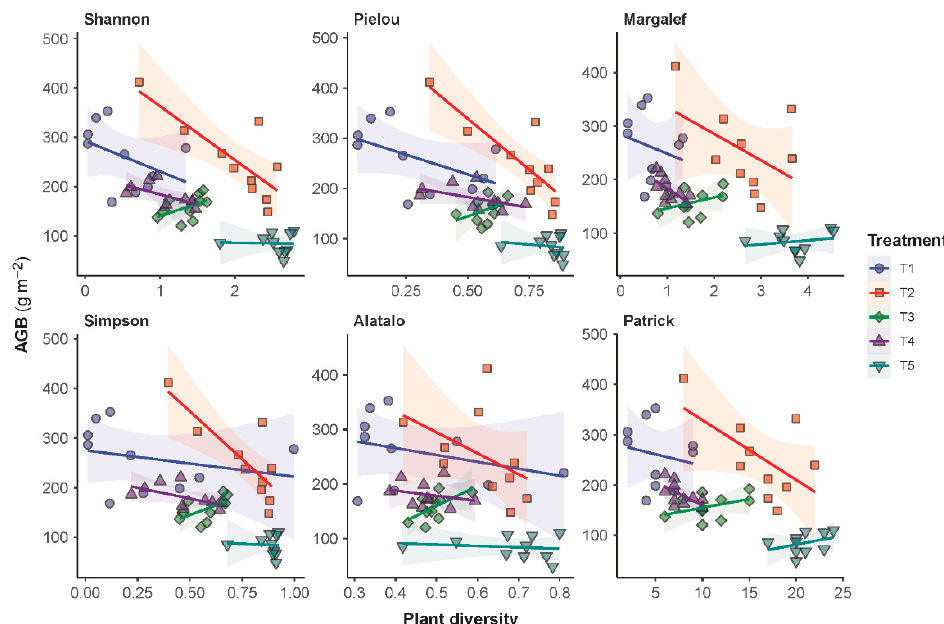
Figure 5. Relationships between the aboveground biomass (AGB) and the species diversity of the plant communities in the sampled grassland. Linear models were fitted to the AGB versus diversity data per experimental treatment. Parameters of the characterized models are given in Table